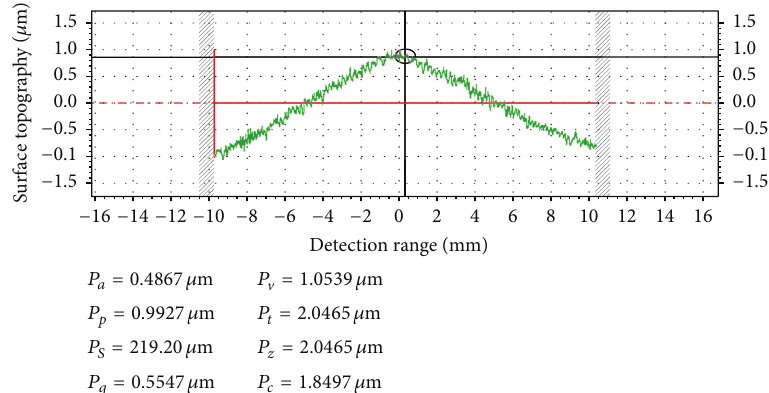
Figure 2: Surface topography of